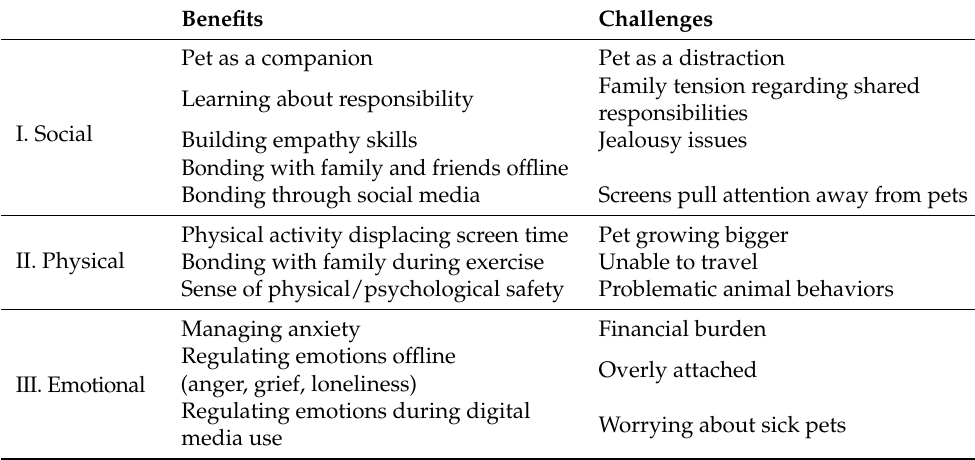
Table 1. Qualitative themes of pet influences on